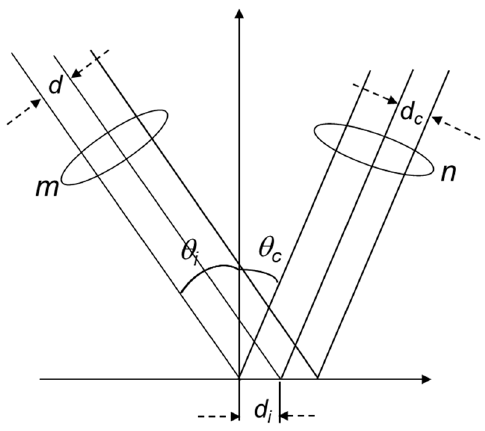
Figure 3. Fringe projection geometry: projection angle θ i , viewing angle θ c , sinusoidal grating pitch d , and lens magnifications m and n of the projection and imaging modules, respectively.